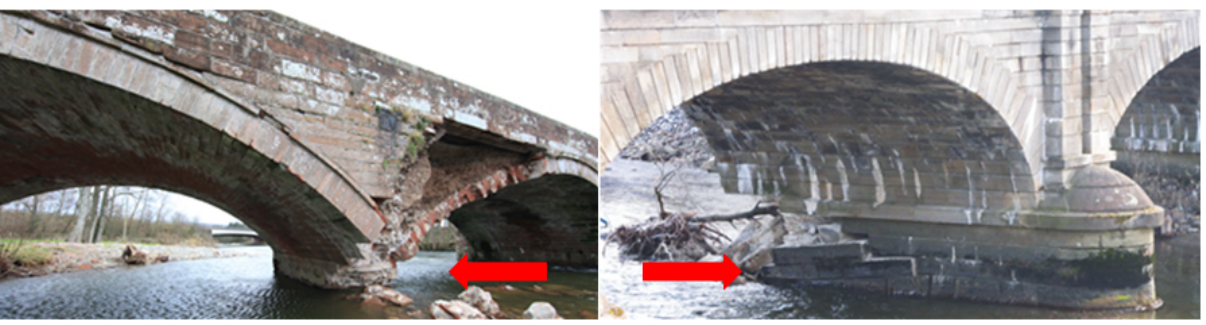
Figure 2. Damage of Brougham Old Bridge (a) and of Calva Bridge (b) , typical of many masonry arch bridges subjected to scour (source: Cumbria Council County for a and Bill Harvey for b ). Flow direction indicated by